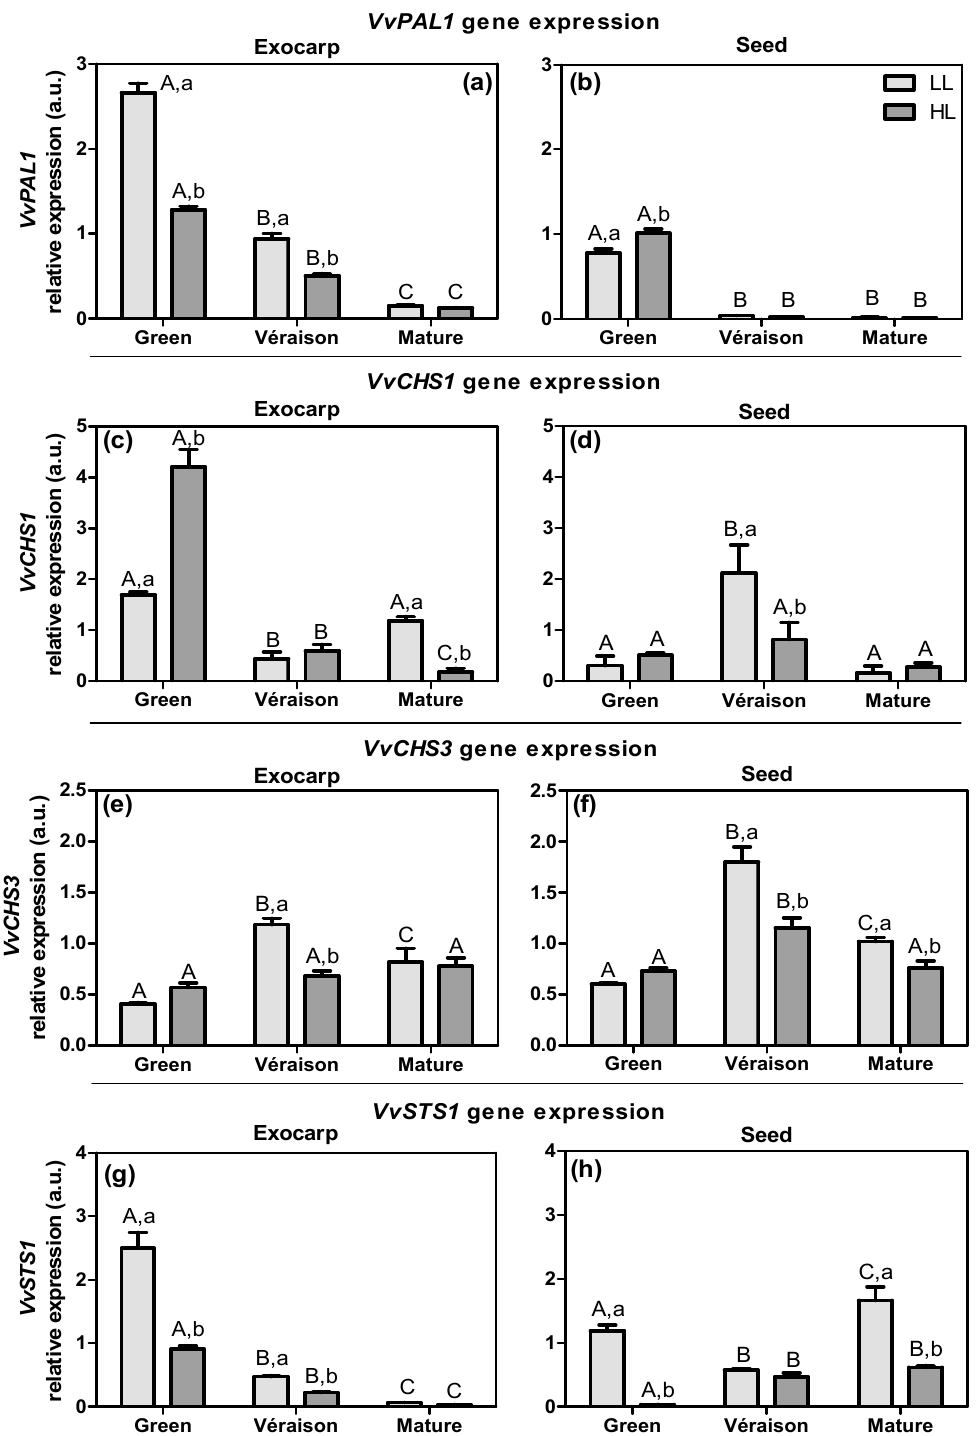
Figure 5. Relative expression in arbitrary units (a.u.) of transcripts of phenylalanine ammonia lyase 1 ( VvPAL1 ) ( a , b ), chalcone synthase 1 and 3 ( VvCHS1 and VvCHS3 ) ( c – f ), and stilbene synthase 1 ( VvSTS1 ) gene ( g , h ), in exocarp and seeds, from berries grown at two distinct light microclimates (LL and HL), and at three developmental stages (green, véraison , and mature), as determined by real-time qPCR. Expression levels are normalized to the mean expression of reference genes VvACT1 and VvGAPDH . Statistical analysis (two-way ANOVA, p ≤ 0.05, n = 3) was applied after data Log(X+1) transformation. Statistical notation: capital letters refer to differences between developmental stages for the same microclimate, and lowercase letters refer to differences between microclimates for each stage. When the letters are omitted, it means that the respective factor did not have a significant